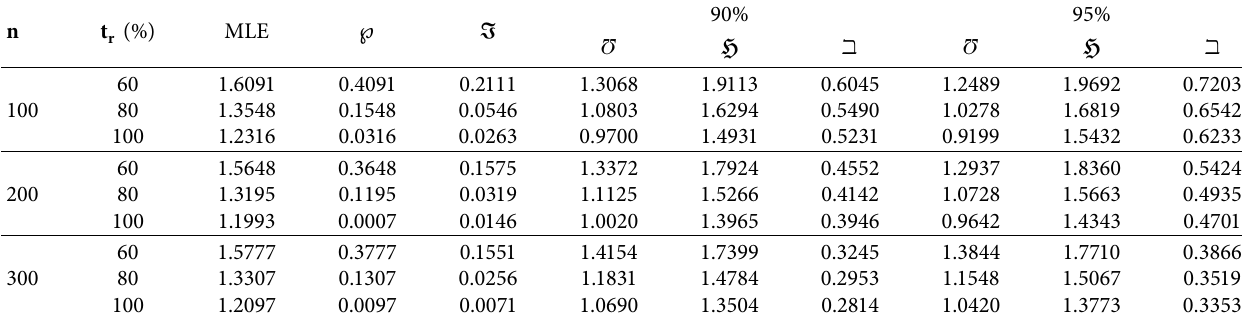
Table 1: MLE, ℘ , I , [ , H , and ℶ of the ILBE distribution for α � 1.2 under TIIC.